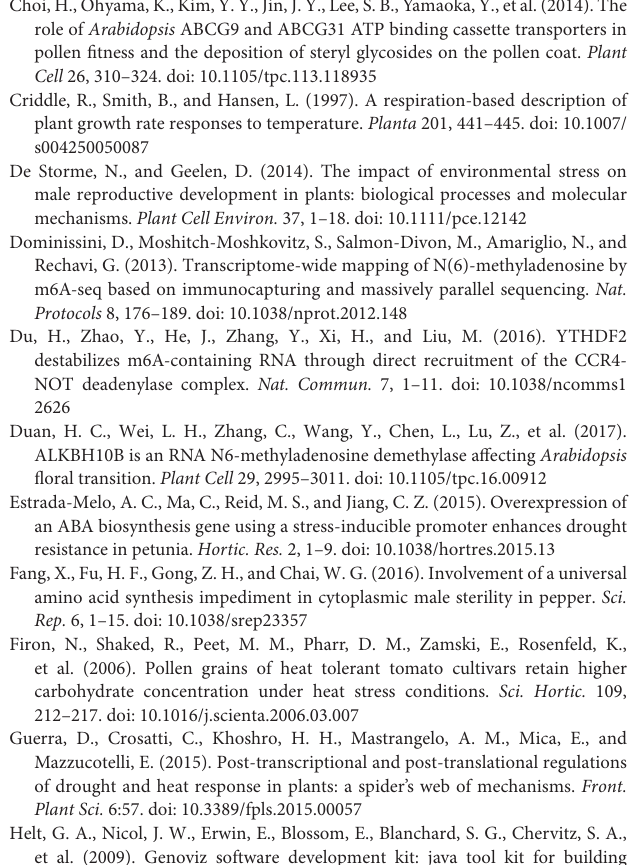
Supplementary Table 1 | Primer sequences used in this study. Supplementary Table 2 | Differential m 6 A peaks and related transcripts between NT and MLT